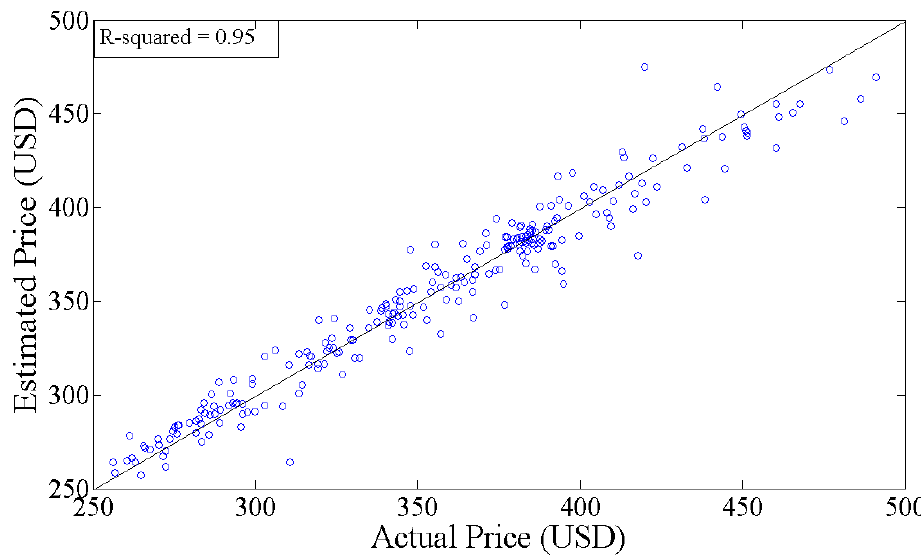
Figure 5. Training data for actual and forecast gold prices.